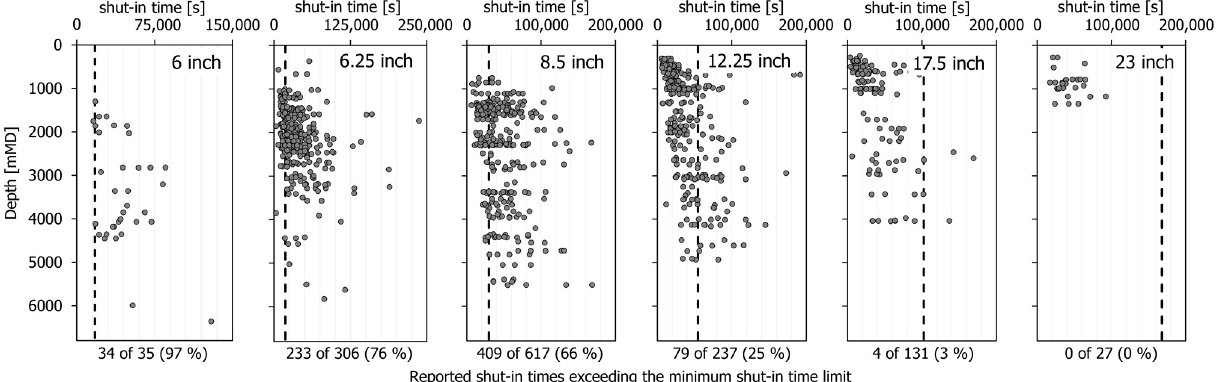
Figure 4. Shut-in times versus depth for the different borehole sections with varying radius a of the Bavarian Molasse Basin data set. The black dashed line marks the calculated limit over which the BHT correction stability criterion a 2 < 4 κ t s is still met for the respective borehole diameter when κ is 1.5 − 7 m 2 /s. Below each subplot, the representation of the data set for the stability criterion is indicated by a